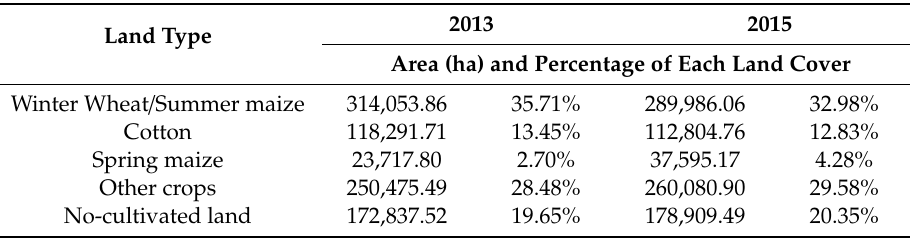
Table 3. The area and percentage of each land cover in 2013 and